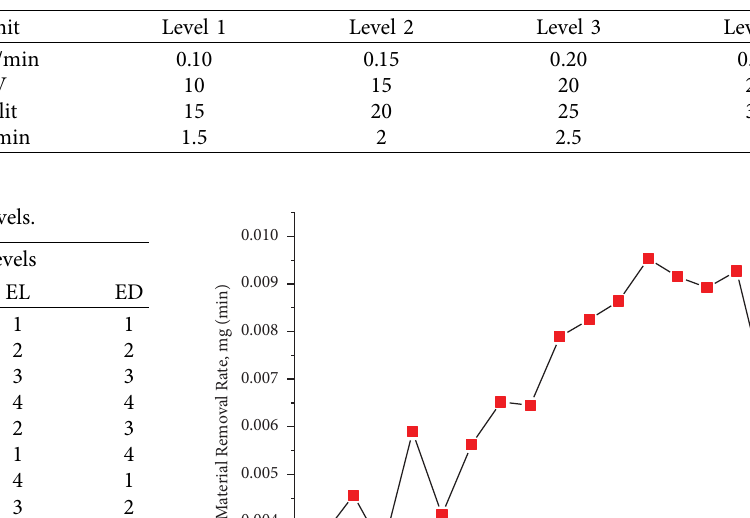
Figure 2: Electro chemical machining (ECM) arrangement. Table 3: ECM parameters with levels.